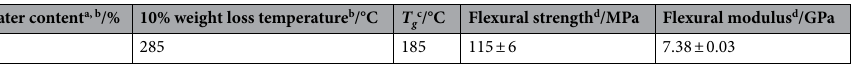
Table 1. Thermal and mechanical properties of BP1. a Calculated by the weight loss below 120 °C. b Measured by thermal gravity analysis (TGA). c Measured by differential scanning calorimetry (DSC). d Measured by three- point flexural strength testing.